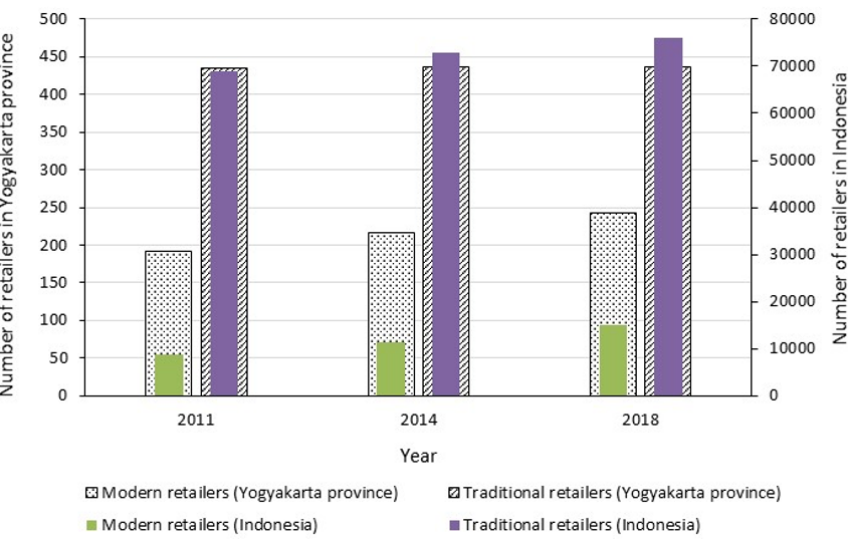
Figure 1. The development of traditional and modern retailers (Bappenas, 2019)